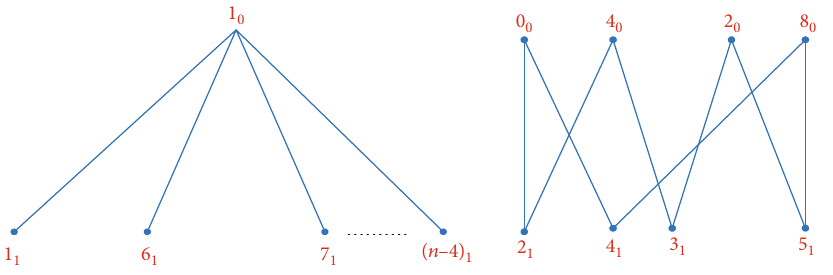
Figure 9: An orthogonal labeling for C